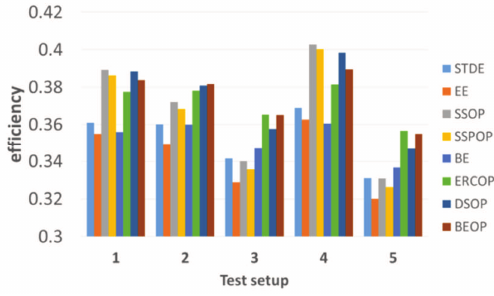
Fig. 16. Comparison of different setups on engine